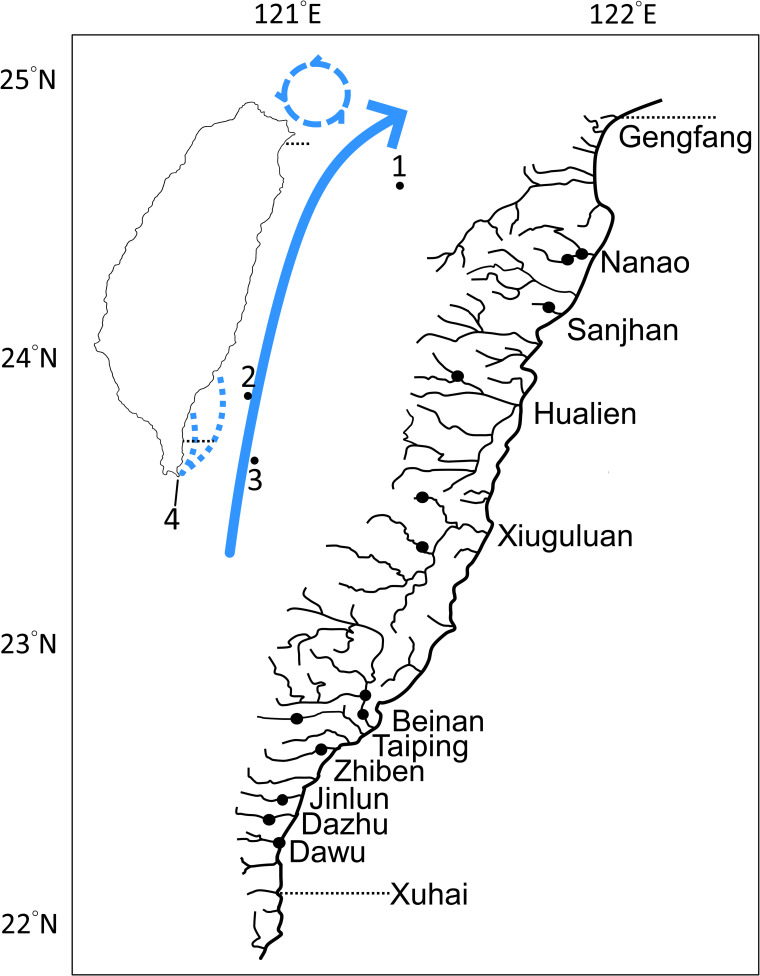
Sampling localities of Rhinogobius gigas in Taiwan.The blue dashed circle marks a counterclockwise eddy in the northeastern coasts of Taiwan. Black dots represent approximate sampling sites along the east coast of Taiwan. Sample sizes are given in Table 1. 1 for Yonaguni; 2 for Green Island; 3 for Orchid Island; 4 for the southernmost cape of Taiwan where cyclonic eddies (blue dotted lines for the area they appear) are formed after hit by the Kuroshio Current (the blue bold arrow).